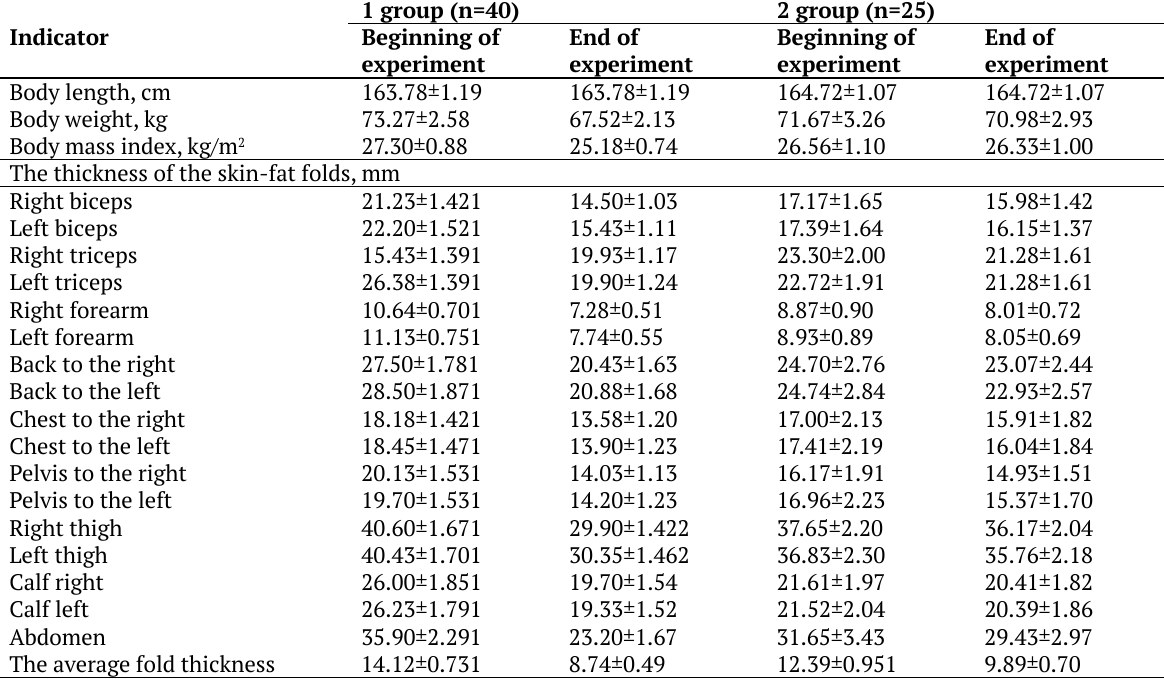
Table 1. Somatometric and somatoscopic indicators of the participants